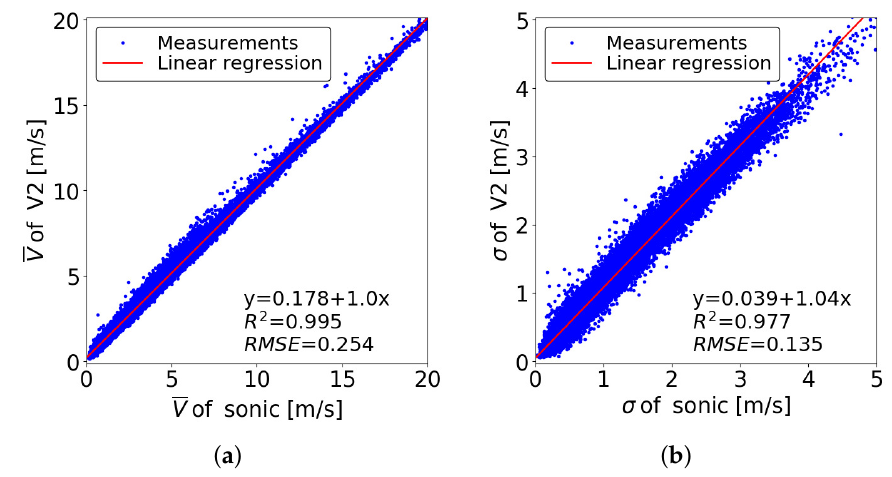
Figure 9. Comparison of measurements at 57 m height. ( a ) 10-min average horizontal wind speed; ( b ) Standard